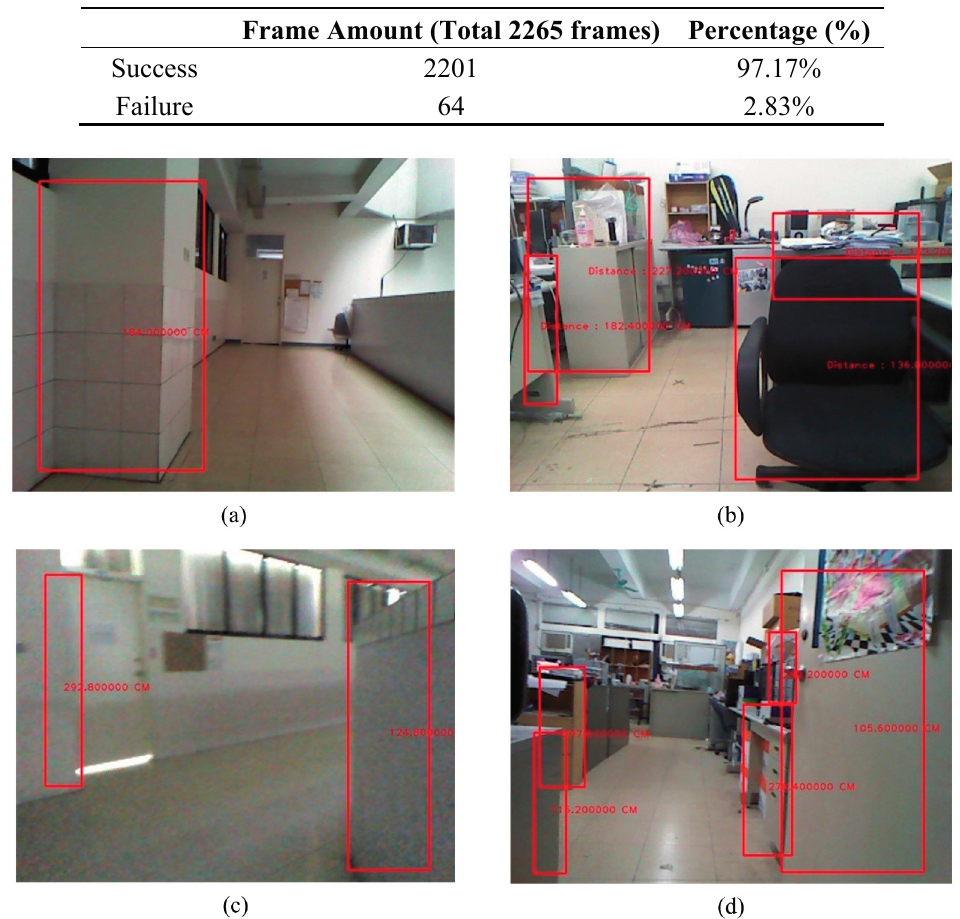
Table 1. The success rate and the failure rate for the detection of obstacles.